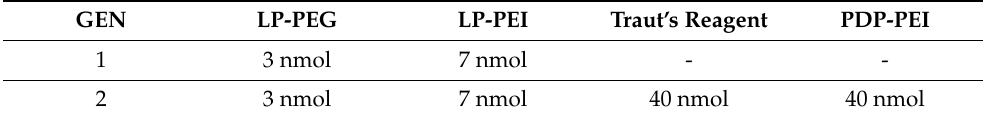
Table 1. Functionalization agents and amount used for use in AuNPs.